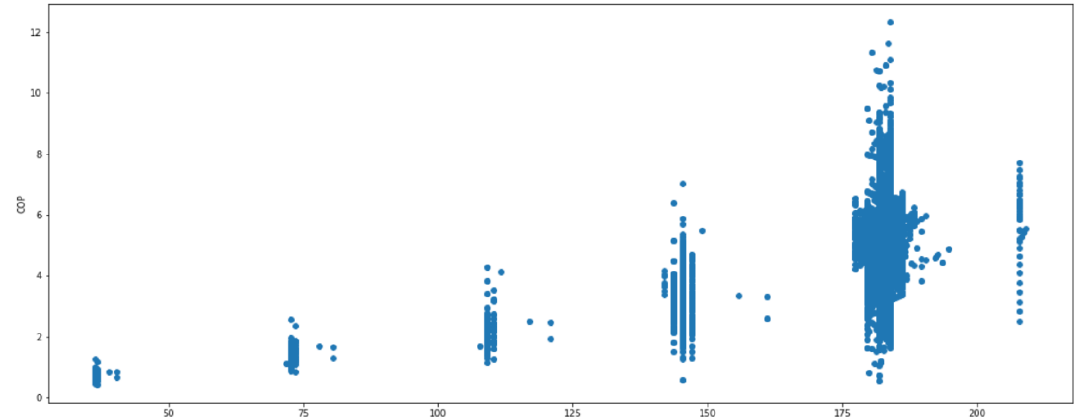
8 of 20 Table 3. Maximal information coefficient of performance (COP). Variables